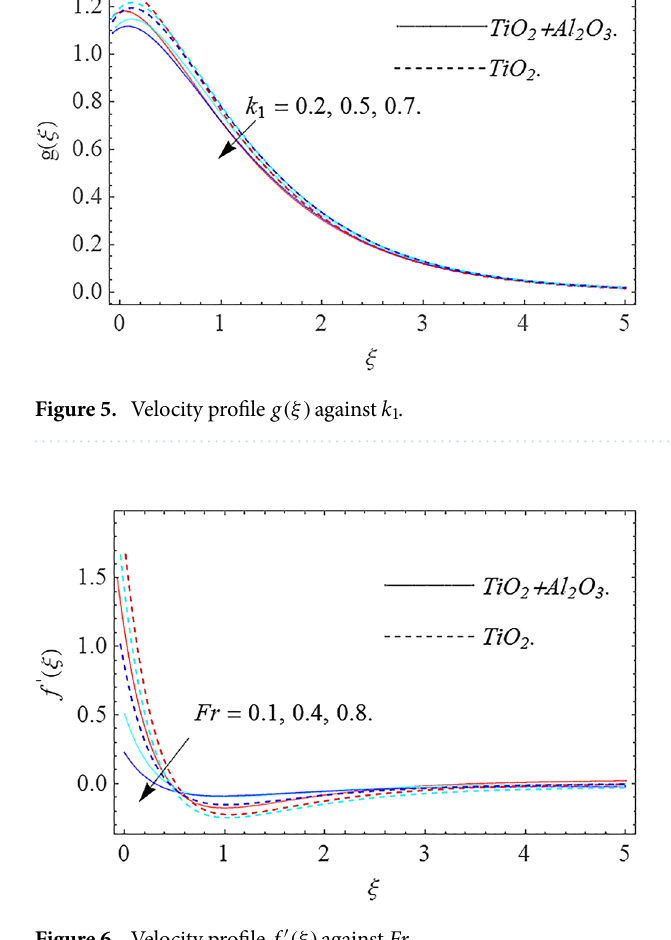
Figure 6. Velocity profile f ′ (ξ) against Fr .